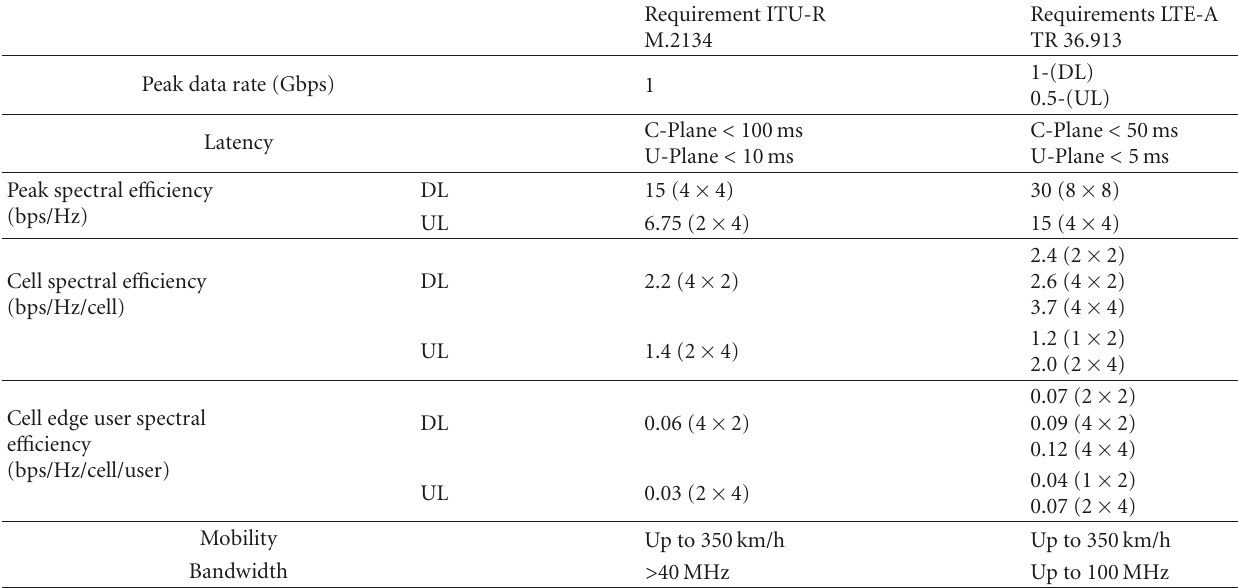
Table 3: IMT-Advanced requirements related to LTE-Advanced